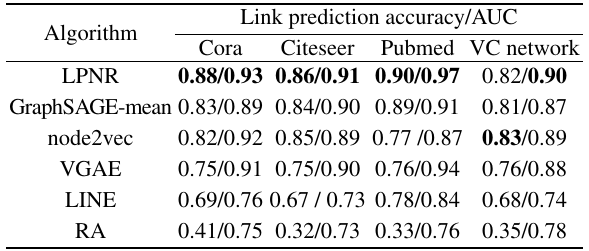
Table 2 Link prediction accuracy and AUC of different algorithms over four networks. Here, VC represents venture